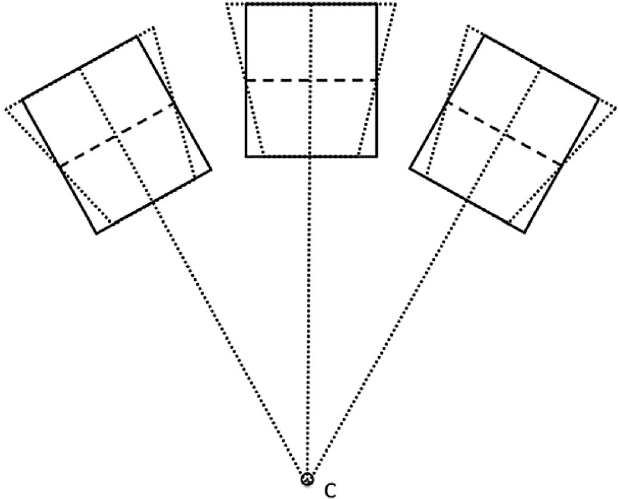
center.FIG. 3. (Color) Cell tunes throughout acceleration for the case of wedge-shaped magnets with different order of truncation. Horizontal cell tune in (a) and vertical cell tune in (b). Dashed lines and associated numbers show total tune of a 12 cell ring.